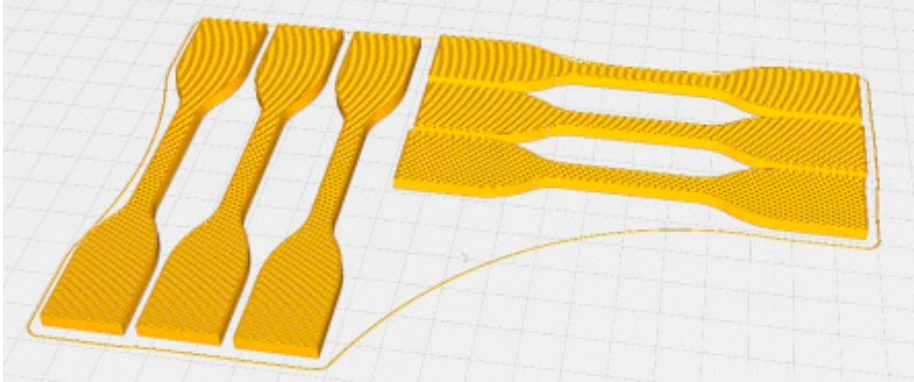
Figure 1. Test specimens on the work table.